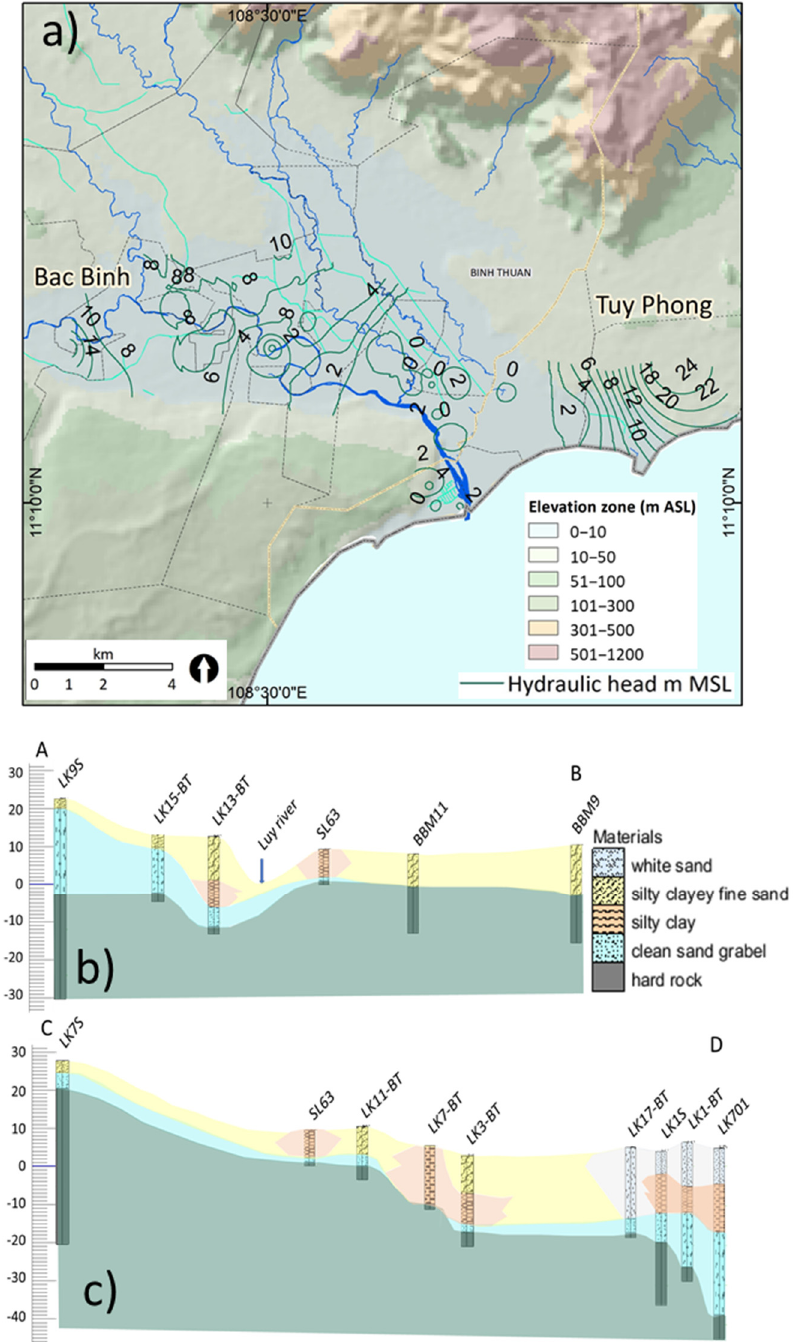
Figure 3. ( a ) The elevation of the water table in the study area measured in the summer 2020 and the hydrostatigraphic cross sections along line AB ( b ) and CD ( c ). The white and red sand dune complexes are characterized by higher water levels. In the upstream part, the piezometric table remains above sea level whereas in the central of the plain and near the coast, the water table is close to sea level or sometimes even below.